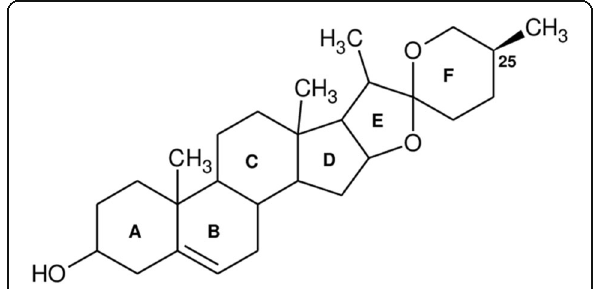
Fig. 2 Chemical structure of diosgenin [44] (Jesus et al.